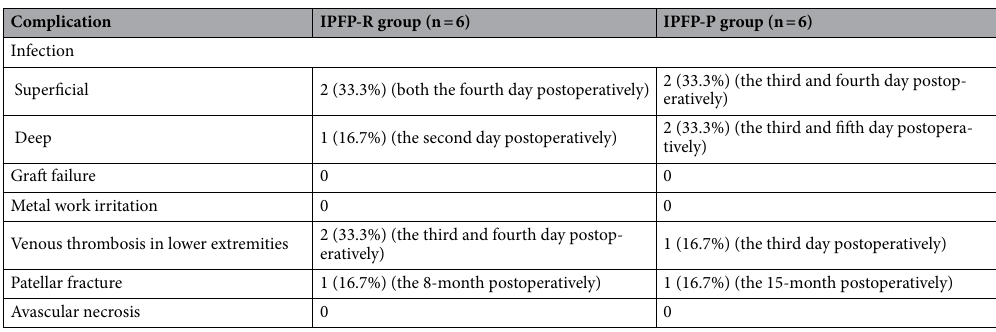
Table 4. Complications in both groups. Values are expressed as n (%). IPFP-R infrapatellar fat pad resection, IPFP-P infrapatellar fat pad